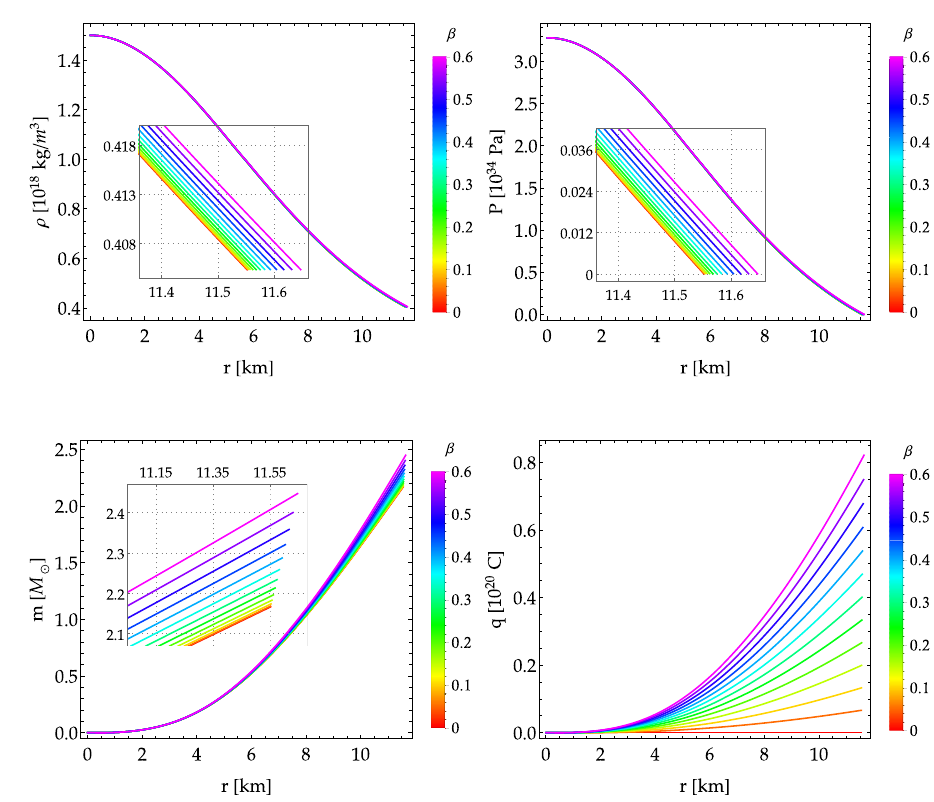
Table 1 Charged quark stars with central mass density ρ c = 1 . 5 × several values of the charge parameter β . The radial behavior of the